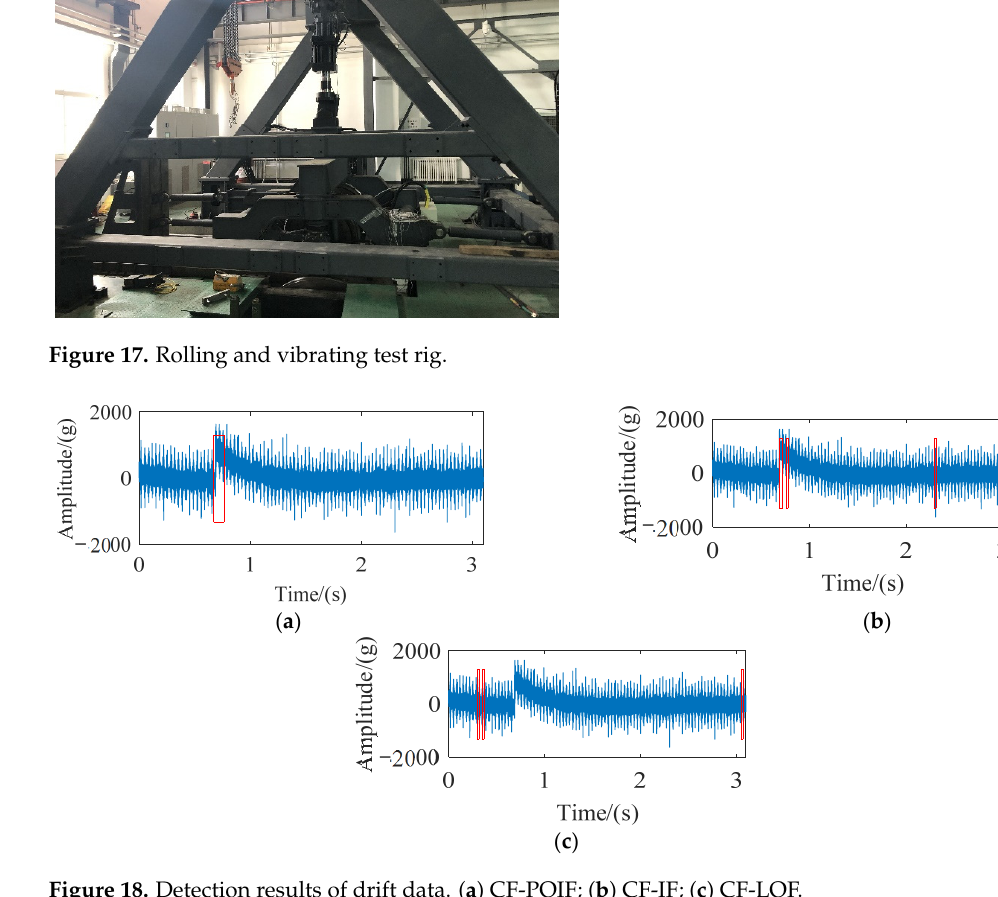
Figure 18. Detection results of drift data. ( a ) CF-POIF; ( b ) CF-IF; ( c ) CF-LOF.